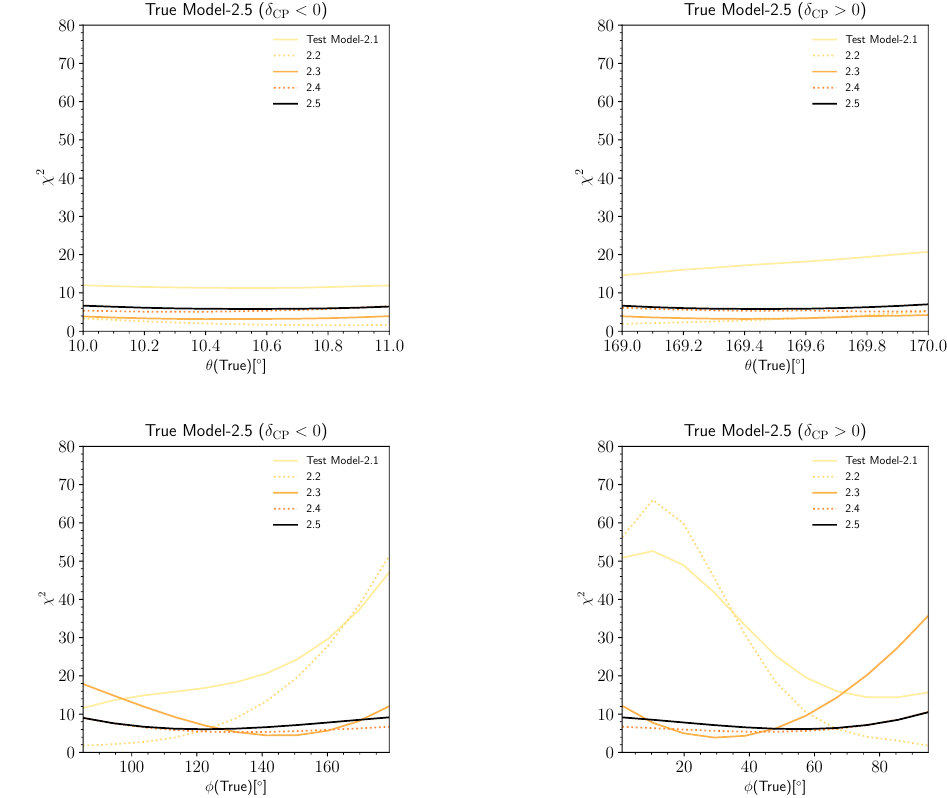
Figure 8 . Comparison among the (cid:12)ve allowed two-parameter models as test models for ESSnuSB using priors in the cases the model parameters (cid:30) (upper row) and (cid:18) (lower row) are minimized and corresponding to the (cid:12)rst (left column) and the second (right column) best-(cid:12)t points in table 8 for Model 2.5 as the true model. For description of each panel, see (cid:12)gure